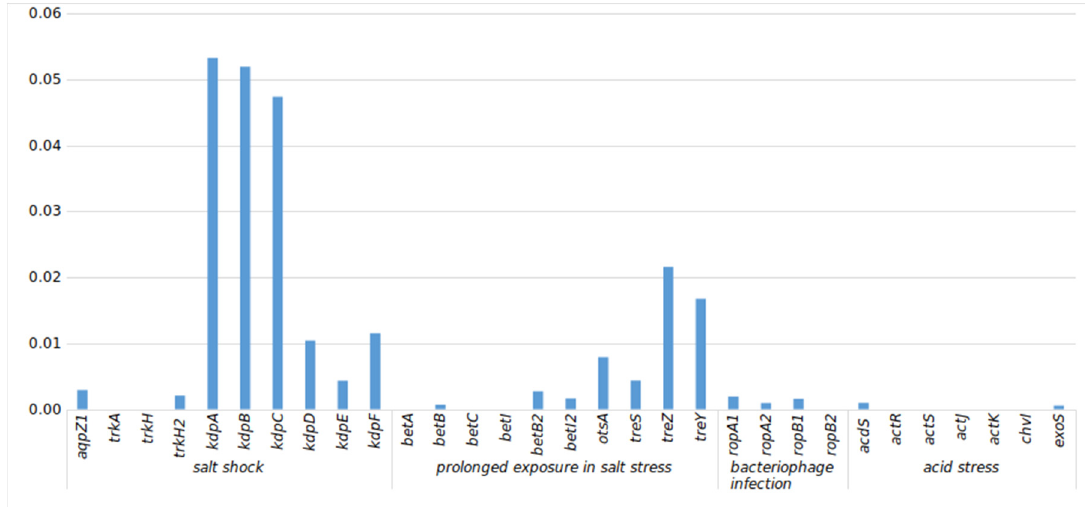
Figure 4. p -distance values for stress genes of E. meliloti strains L6-AK89 and Rm1021.